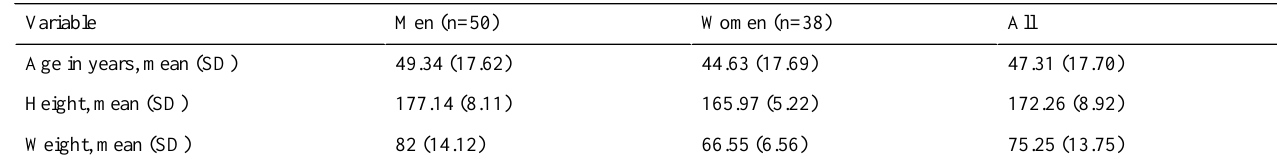
Table 1. Characteristics of patients in study 1.